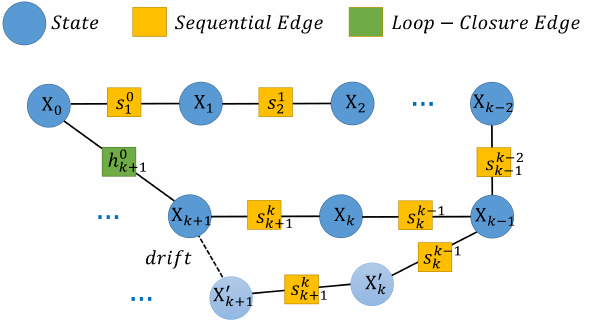
Figure 7. Constructing a pose-graph: every node in the graph represents the state of a keyframe. S is the set of the sequential edges, where S = edges, where H =